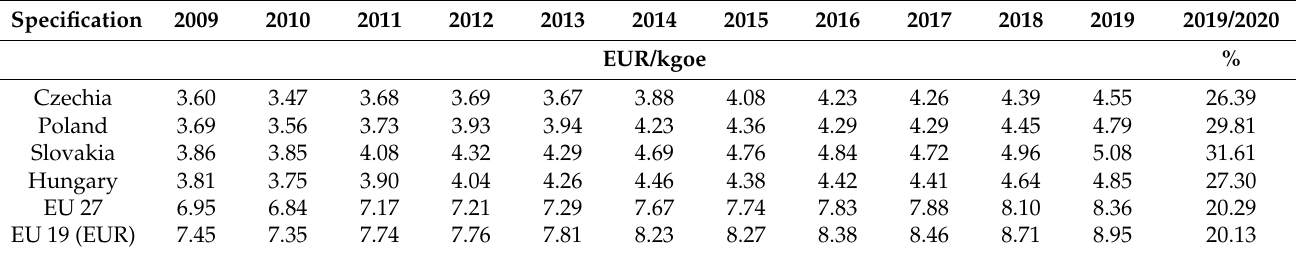
Table 6. Energy productivity in the Visegrad Group countries in 2009–2019 [37].